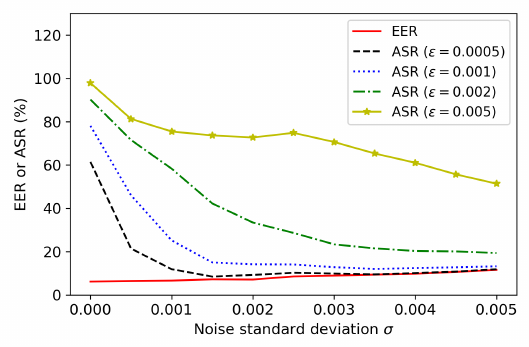
Figure 6. Performance of the strategy of bypassing the plugin function by adaptive FakeBob attacks with different (cid:101) in GMM SV